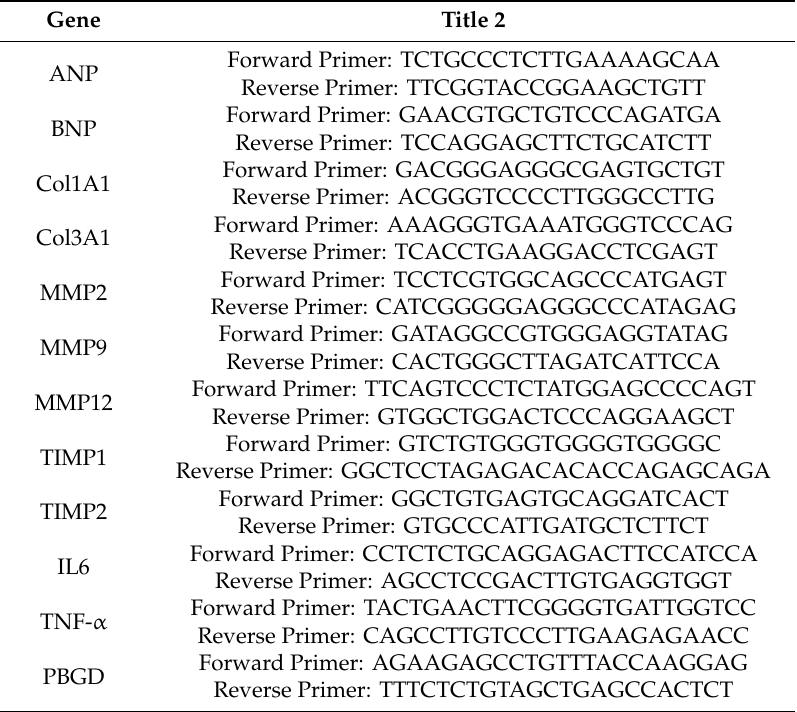
Table A1. Sequence of the primers used in quantitative real-time PCR